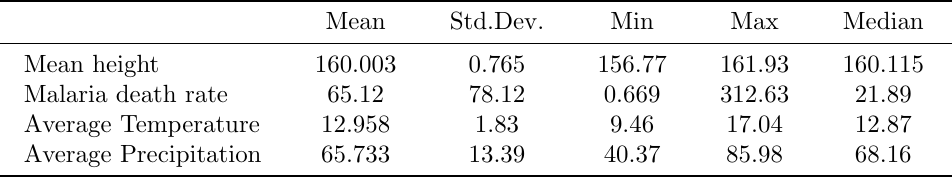
Table 1: Summary of statistics (Italy) Mean Std.Dev.